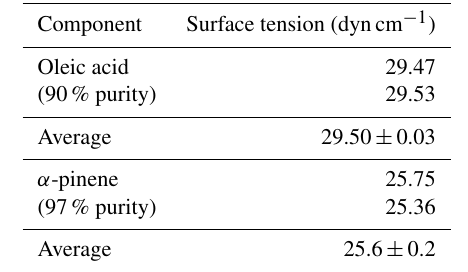
Table 1. Surface tension of bulk liquids used for standardization, measured by the Wilhelmy plate at 23.9 ◦ C. Averages reported as √ n) ”. Pure oleic acid has a surface “average ± standard error ( s/ tension of 32.79dyncm − 2 at 20 ◦ C (Chumpitaz et al., 1999), and pure α -pinene has a surface tension of 26.0dyncm − 1 at 25 ◦ C (Daisey and Hopkey, 1993). Measured values on Wilhelmy plate are close to reported values, considering differences in purity and temperature.